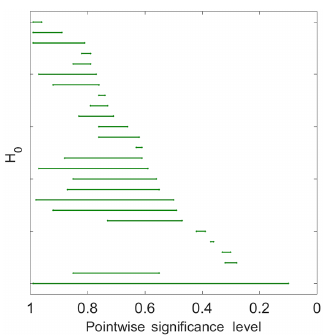
Figure 6. Example barcode for H 0 corresponding to a wavelet power spectrum of a red-noise process with length 150 and ρ = 0 .